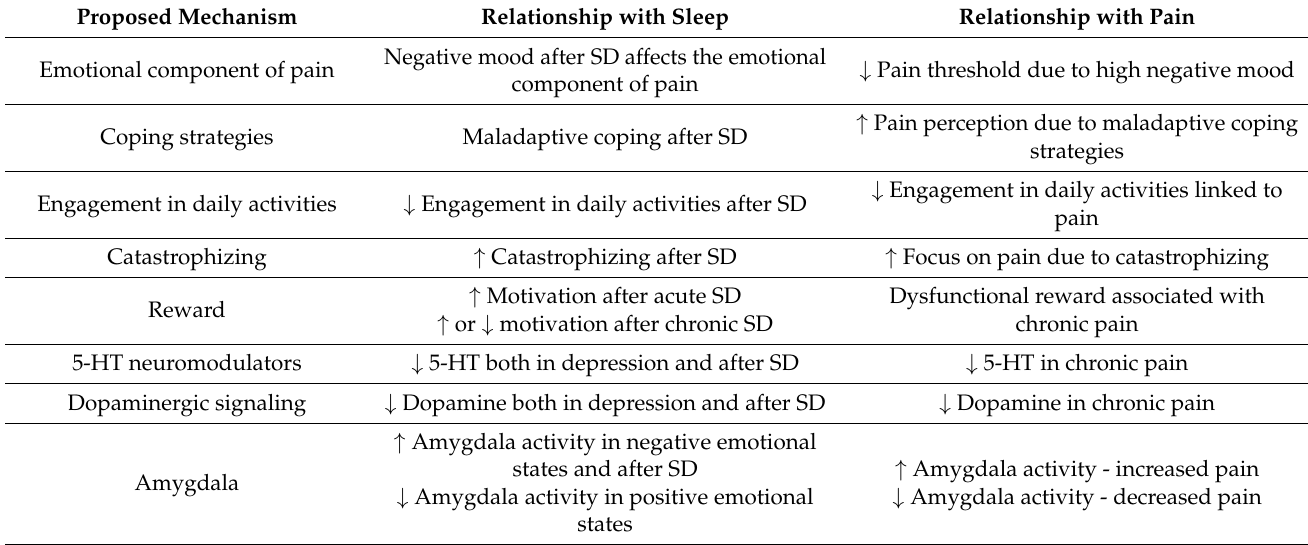
Table 2. Summary of mechanisms to explain the effect of sleep on the psychological component of pain. Proposed Mechanism Relationship with Sleep Relationship with